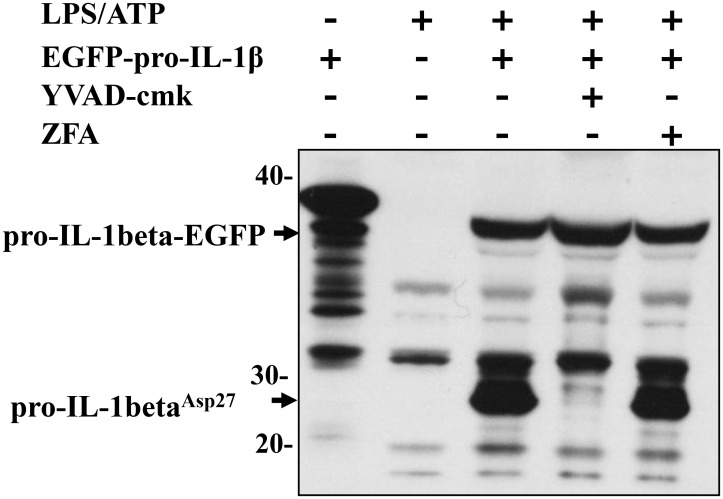
Extracellular caspase-1 is able to cleave pro-IL-1β.THP1 cells (2x109 cells/ml) were left untreated or stimulated with LPS/ATP for 1h and then supernatants were incubated with lysates from HEK293 cells expressing proIL-1β-EGFP for 12h at 37°C in the presence or absence of YVAD-cmk (100 μM) or z-FA-fmk (100 μM apoptotic caspase inhibitor, negative control) and immunoblotted for IL-1β. Representative gel from n = 3 independent experiments. Asp27cleavage product of EGFP-proIL-1β detected.